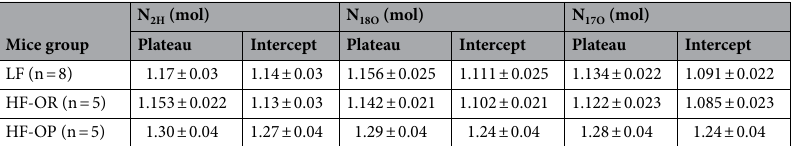
Table 6. The dilution space calculated using either 2 H (N 2H ), 18 O (N 18O ) and 17 O (N 17O ) with the plateau or intercept methods for the three mice groups. The values are expressed as mean ±